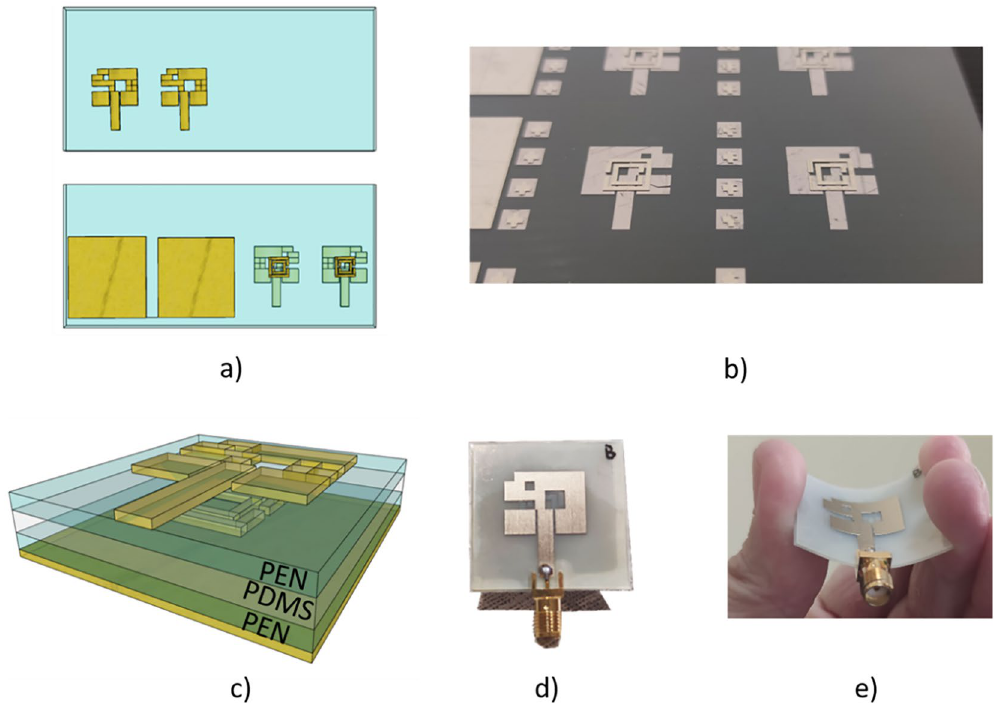
Figure 5. ( a ) Steps of the 3D printing process, ( b ) result of the alignment between patch and SRR and printed ground planes, ( c) representation of the multilayer antenna with the interlayer of PDMS, ( d ) flat and ( e ) bent fabricated prototype with SMA connector. Software used: Rhino